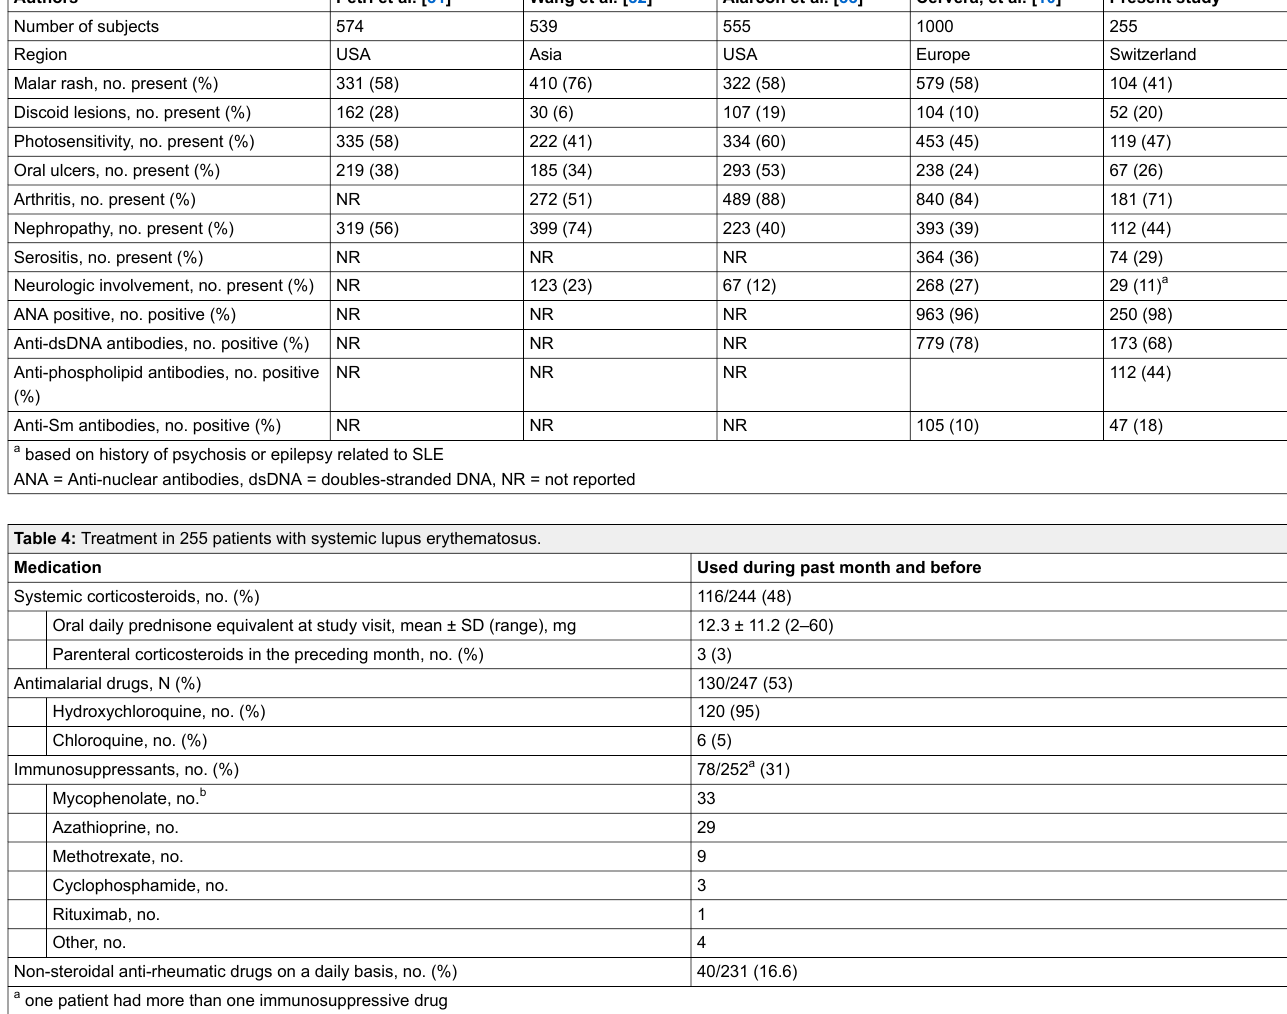
Table 3: Disease characteristics at baseline in comparison with other cohorts. Authors